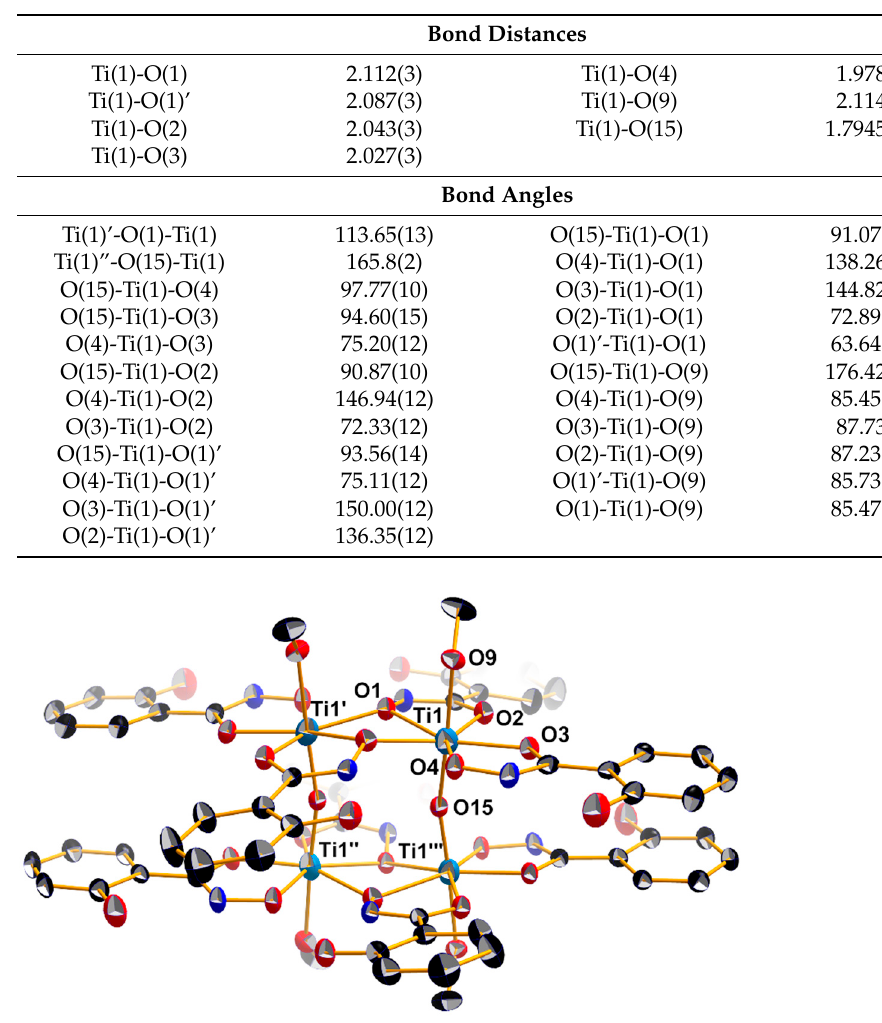
Table 1. Interatomic distances (Å) and angles ( ◦ ) relevant to the Ti( 1 ) coordination sphere for the tetranuclear titanium cluster 1 .